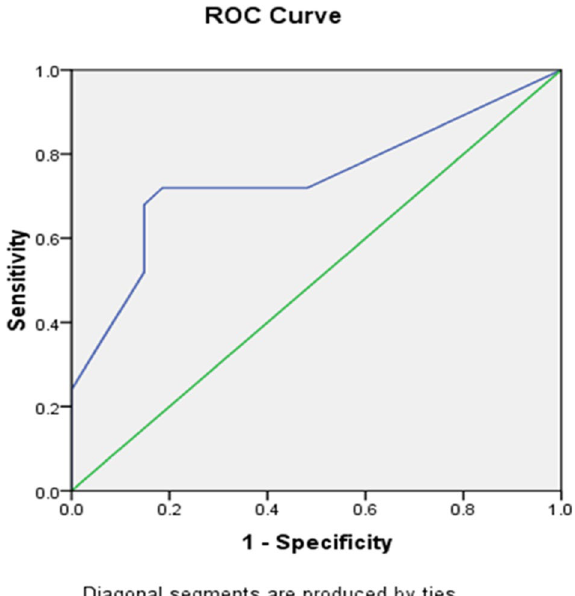
Fig. 3 ROC curves to detect the optimum cut‑off values of delta B lines for predicting failure of weaning